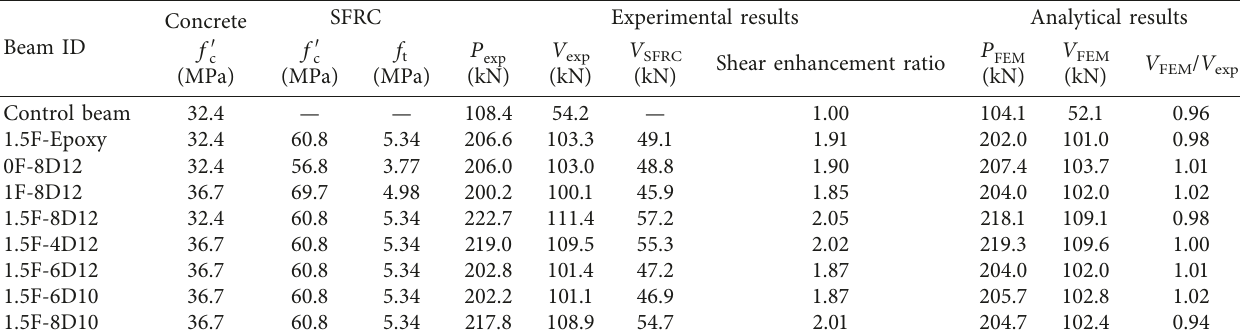
Table 5: Comparison between experimental and analytical results.